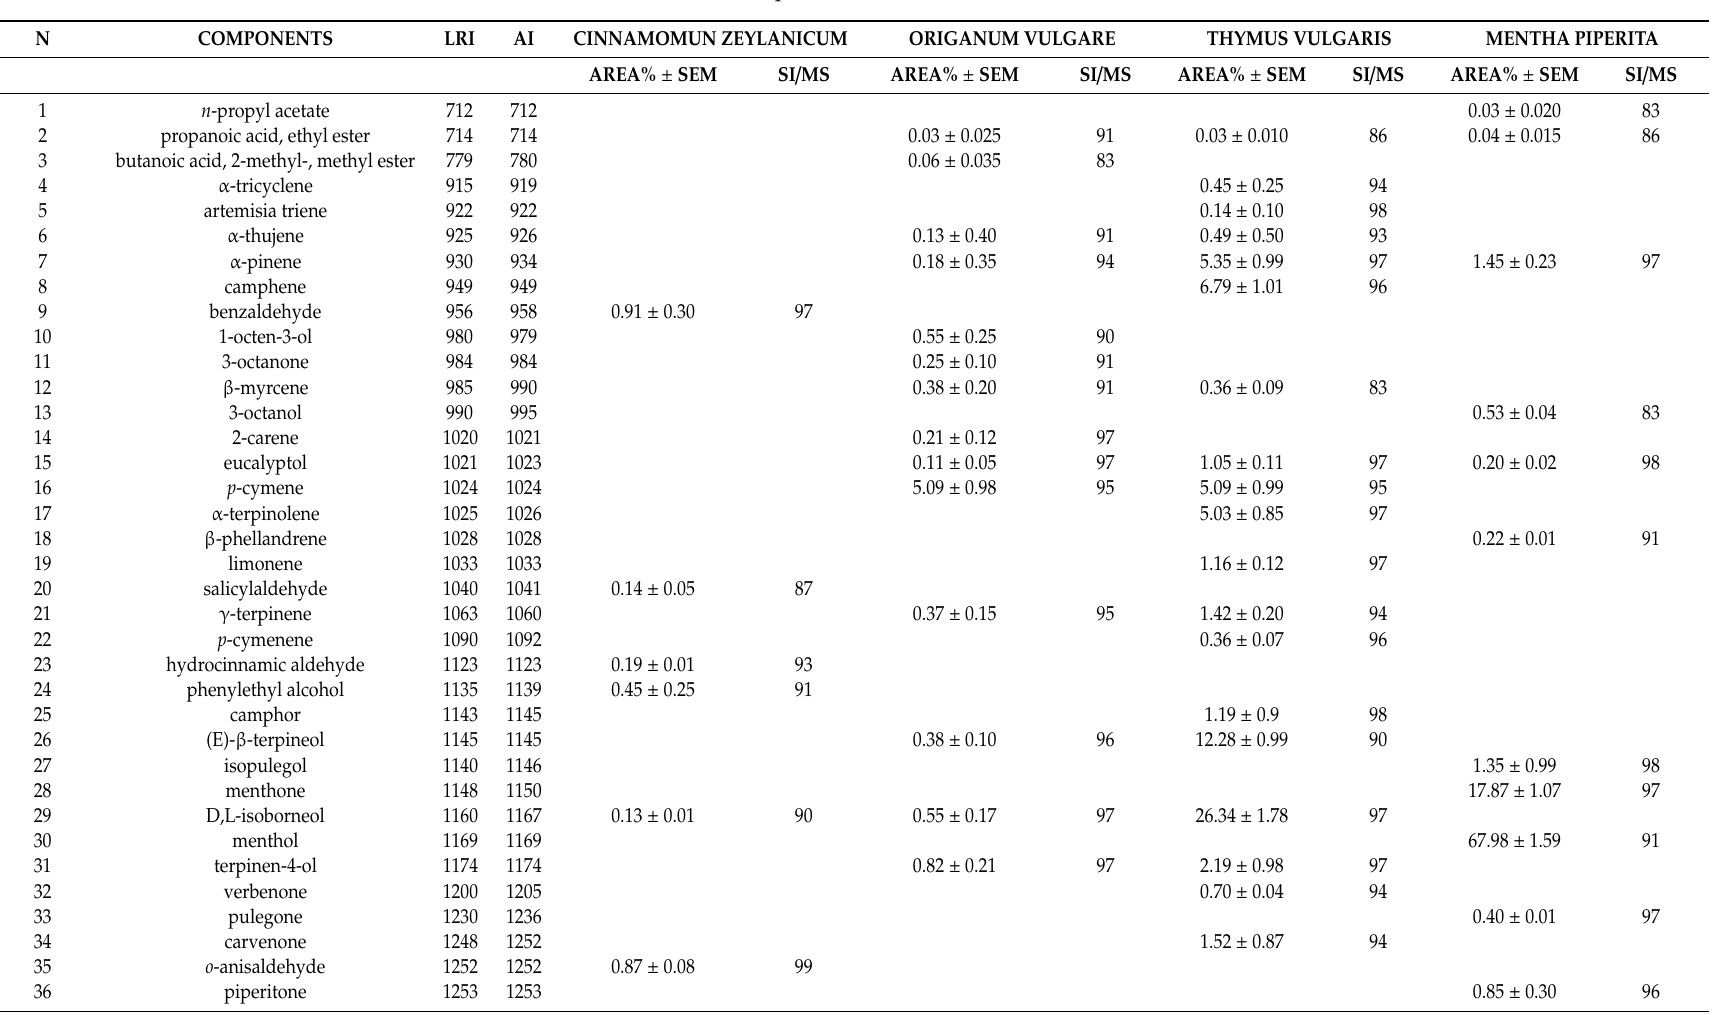
Table 1. Chemical composition of tested essential oils